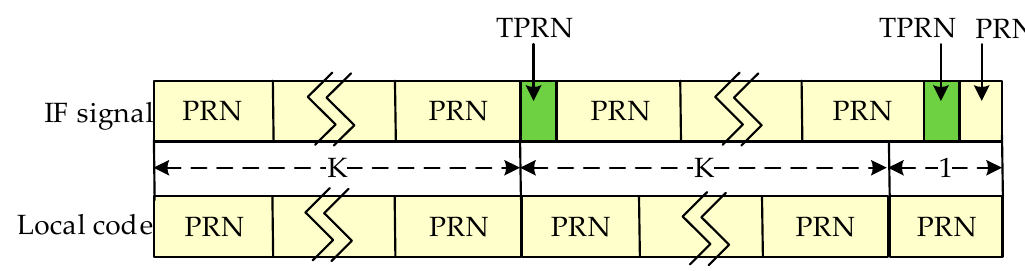
Figure 9. A condition of MFADD.